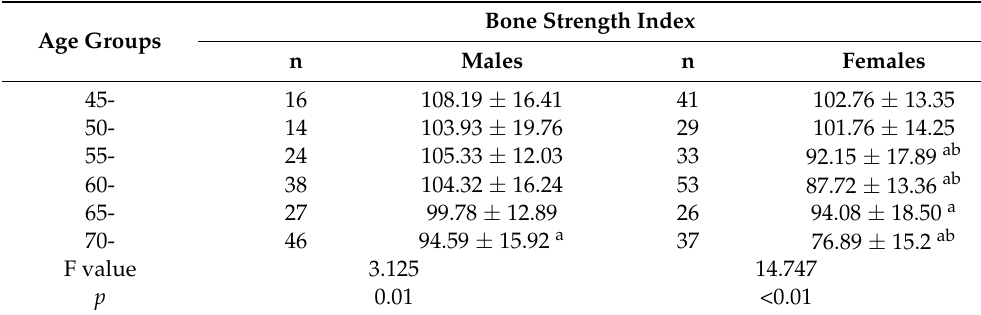
Table 1. Result of bone strength index.